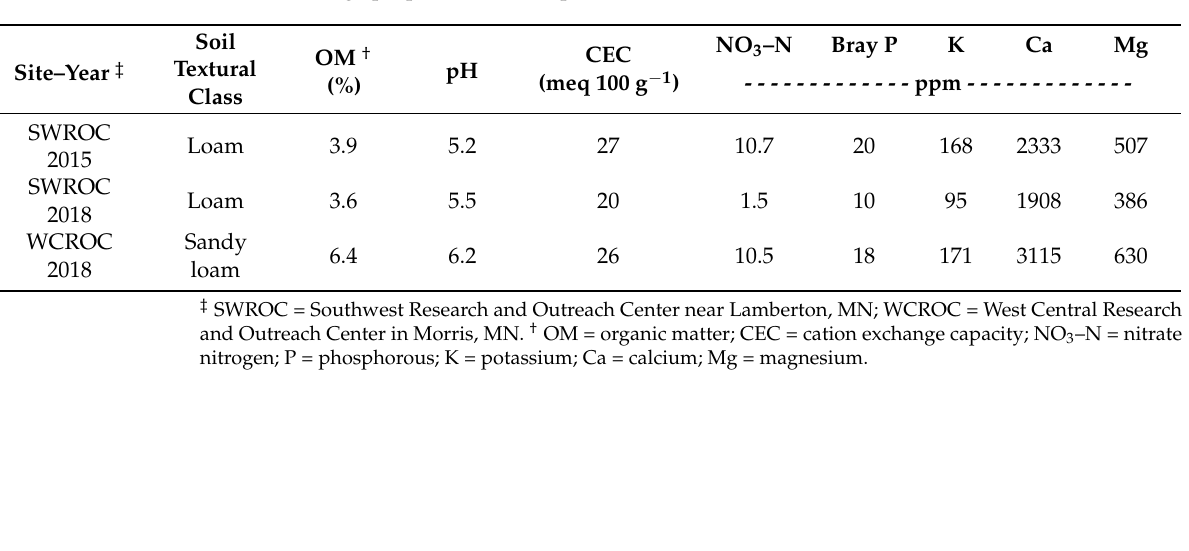
Table 1. Average properties of the top 30 cm of soil at the SWROC and